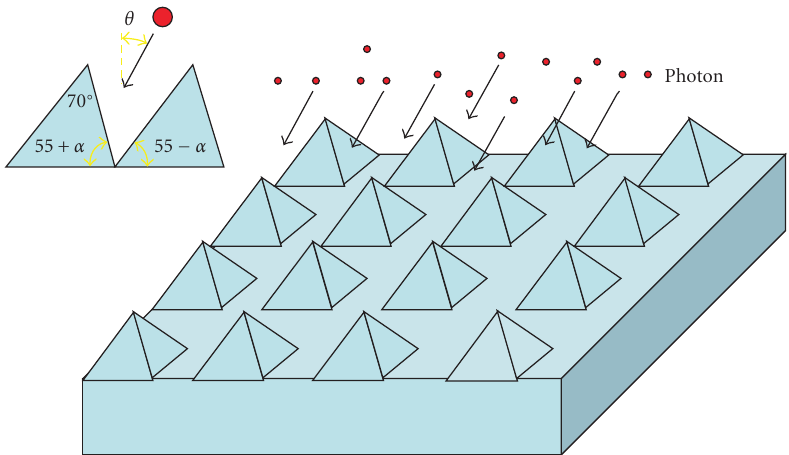
Figure 2: The model of mc-silicon by alkaline etching. The tilted angle is α .